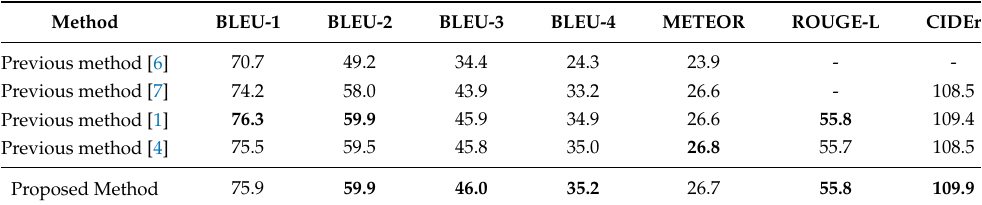
Table 3. Results of experiment 4 with MSCOCO dataset. Proposed method: For motion features, estimated optical flow was used. The best value for each metric is shown using bold